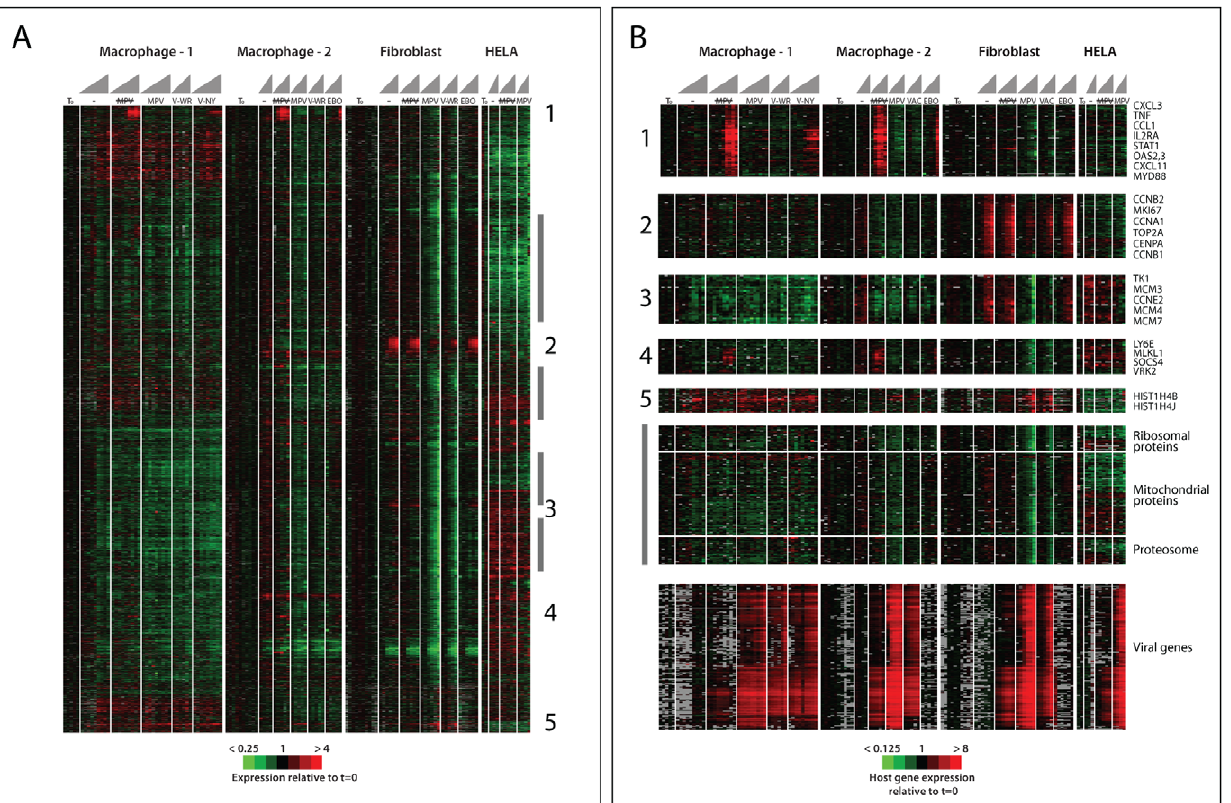
Figure 1. Host Gene Expression Overview. An overview of the gene expression patterns of 5745 genes whose transcript levels changed, by a factor of at least 3, from their initial levels in at least one of the 134 samples taken from time courses viral infection or mock infection in macrophages from two human donors, human dermal fibroblasts, or HELA cells. In this display, genes were hierarchically clustered based on similarities in the patterns of variation of their transcript levels [43]. In this display, each row represents a single gene, and each column represents a single cell sample from an infection or mock infection time course. The samples from each time course are ordered from left to right. Red and green colors represent expression levels greater or less, respectively, than baseline values (average of 2–5 samples taken immediately prior to infection, 0 hour time point). Grey indicates missing or excluded data. The intensity of the color reflects the magnitude of the change from baseline (Time zero), as indicated by the color scales at the bottom of each panel. Mock=mock infection (media only), V-WR=Vaccinia-Western Reserve, V-NY=Vaccinia-New York Board of Health (Wyeth, Dryvax), MPV=killed (gamma irradiated) Monkeypox-Zaire, MPV=Monkeypox-Zaire. Names of a few selected genes or categories of genes from clusters with distinctive patterns of induction or repression, are indicated to the right of enlarged views of the corresponding clusters, in panel B. Numbers to the right of panel A indicate the positions of the clusters shown enlarged and identified by the corresponding numbers in panel B. The vertical grey bars to the right of panel A indicate the positions of the genes encoding ribosomal proteins, mitochondrial proteins and proteosome components, shown in an enlarged view in panel B). For a comprehensive, browseable view of the gene expression programs depicted here, see the supporting information. The complete raw data from this experiment are available at: www.smd.stanford.edu or the GEO database (accession number GSE24125).